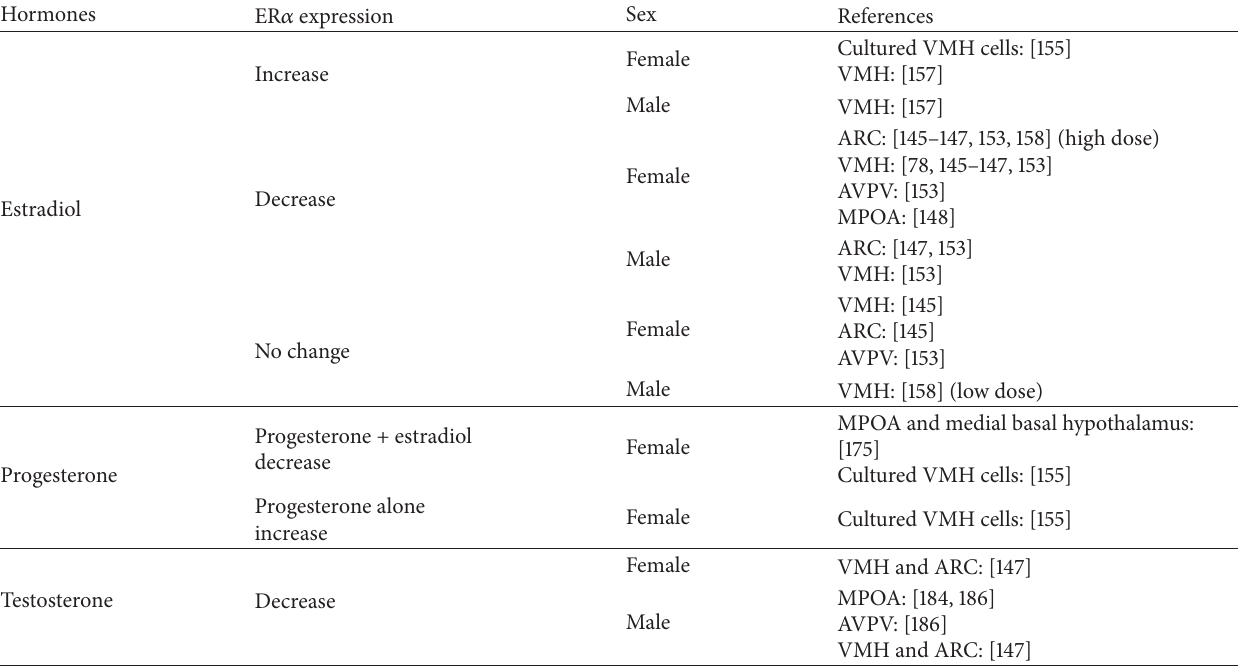
Table 1: Regulation of ER 𝛼 in the hypothalamus by treatment of steroid hormones in male and female rats.